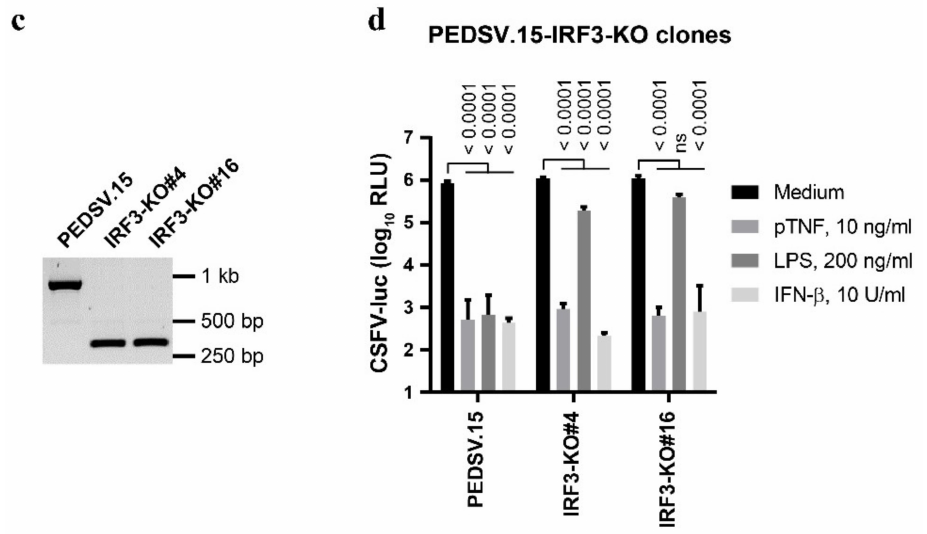
Figure 3. The anti-CSFV activity of TNF requires IFNAR1, while IRF3 is dispensable. PEDSV.15 cells lacking functional IFNAR1 or IRF3 were generated using CRISPR/Cas9-based genome editing by targeting early exons with two separate gRNAs each. ( a , c ) PCR amplifications of the IFNAR1 ( a ) and IRF3 ( c ) loci are shown for the parent cells and for two knockout cell clones each. A Cas9- exposed clone with a functional receptor (IFNAR1-WT#4) served as the negative control. ( b , d ) The IFNAR1- ( b ) or IRF3-KO cells ( d ) were stimulated with pTNF, LPS, IFN- β or the medium for seven hours followed by infection with CSFV-luc at a MOI of 0.1 TCID 50 /cell for 22 h before cell lysates were processed for firefly luciferase measurement. The data in ( b , d ) represent the means and the standard deviations of six independent experimental replicas. Significant differences compared with the medium ( p < 0.05) were calculated with one-way ANOVA and post hoc tests (the p -values are indicated; ns,